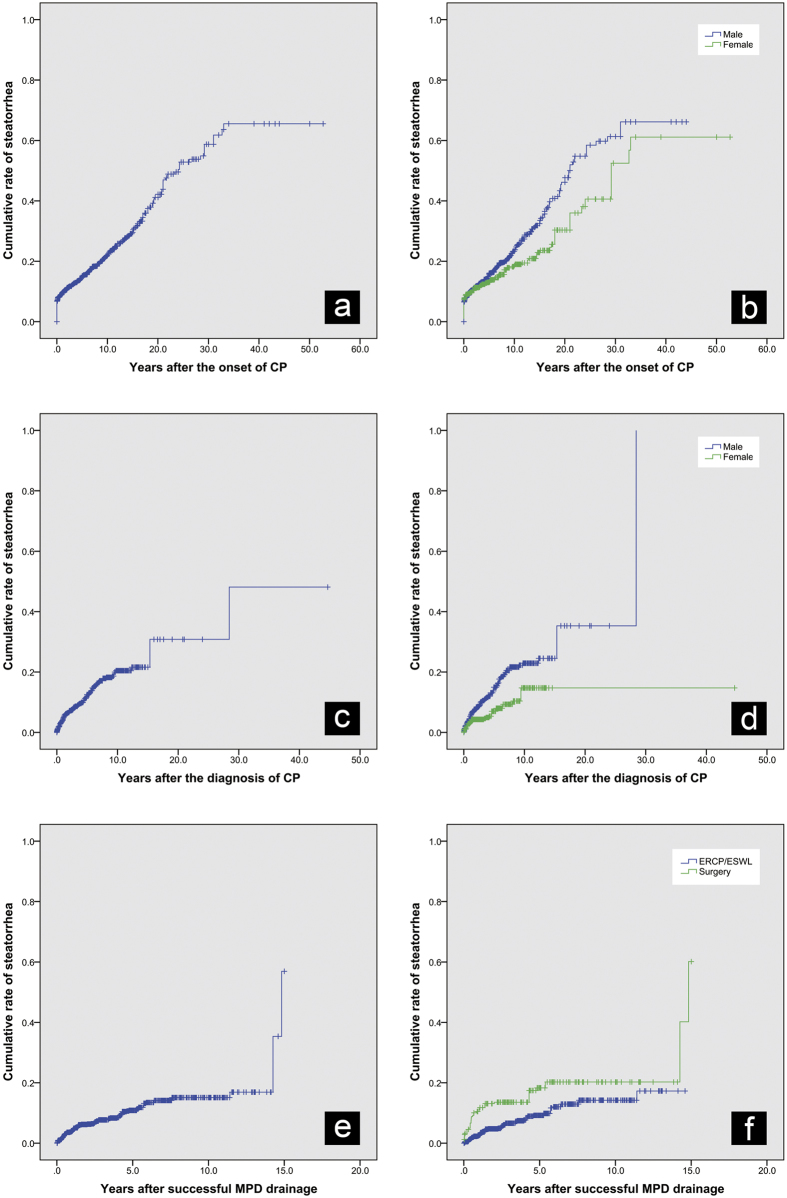
Cumulative rates of steatorrhea.(a) Overall cumulative rate of steatorrhea after the onset of chronic pancreatitis (CP); (b) Cumulative rates of steatorrhea stratified by gender (male vs. female) after the onset of CP; (c) Overall cumulative rate of steatorrhea after the diagnosis of CP; (d) Cumulative rates of steatorrhea stratified by gender (male vs. female) after the diagnosis of CP; (e) Overall cumulative rate of steatorrhea after successful main pancreatic duct (MPD) drainage; (f) Cumulative rates of steatorrhea stratified by method for MPD drainage (ERCP/ESWL vs. surgery).